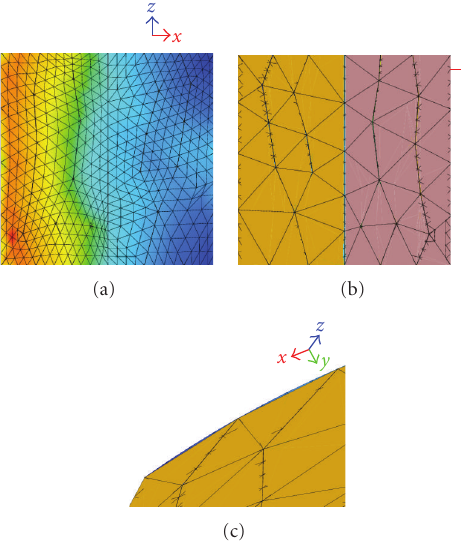
Figure 14: Detail of the di ff erence between adapted projected mesh and the original grid of one side of the blade, view from—(a) outside, (b) inside and (c) top with gap detail.